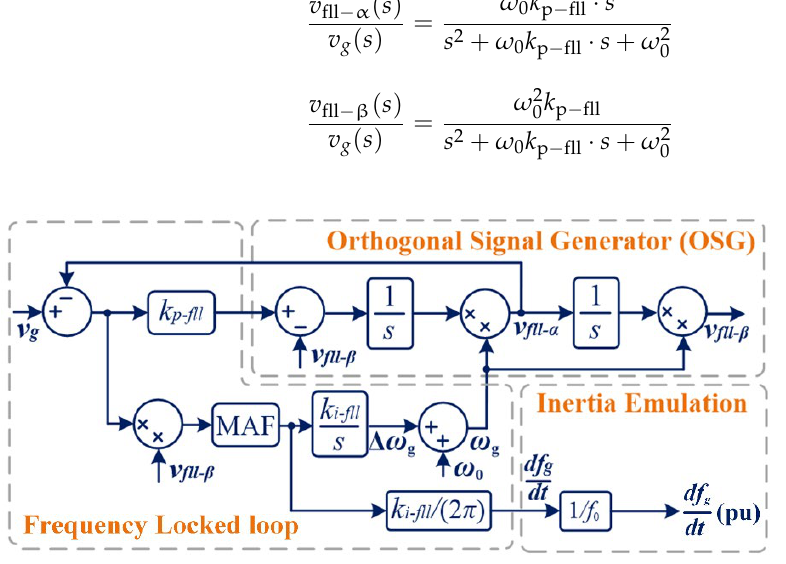
Figure 7. Control block diagram of the FLL-based RoCoF acquisition.